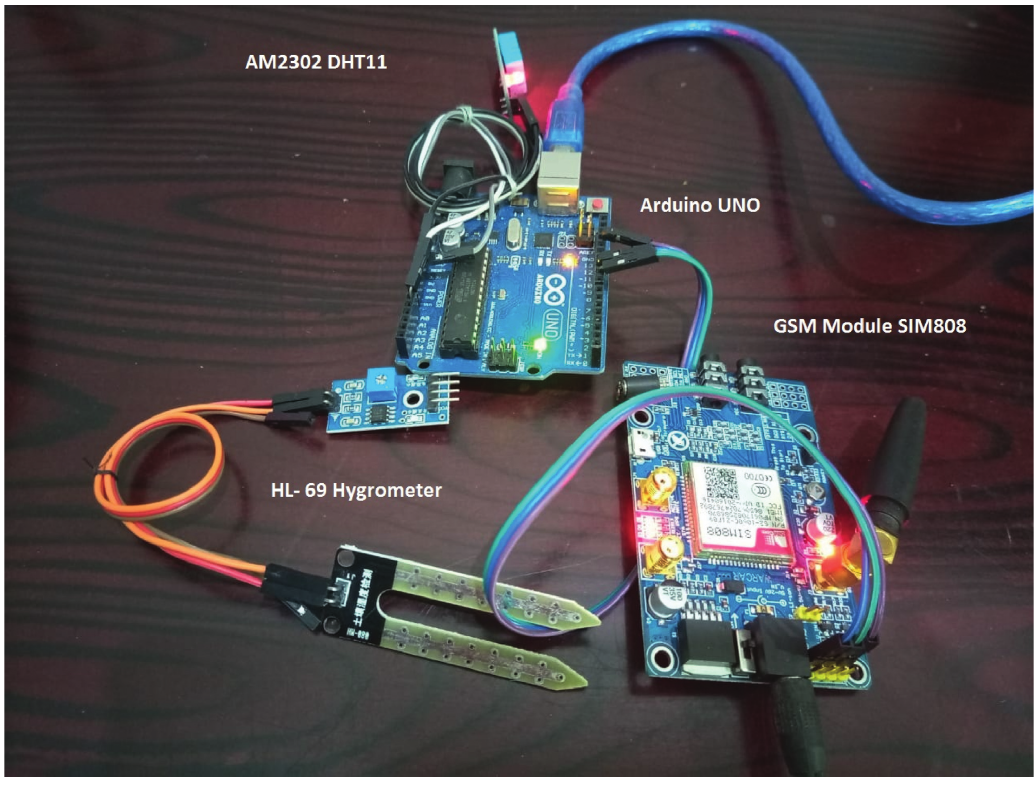
Figure 5: Hardware prototype.